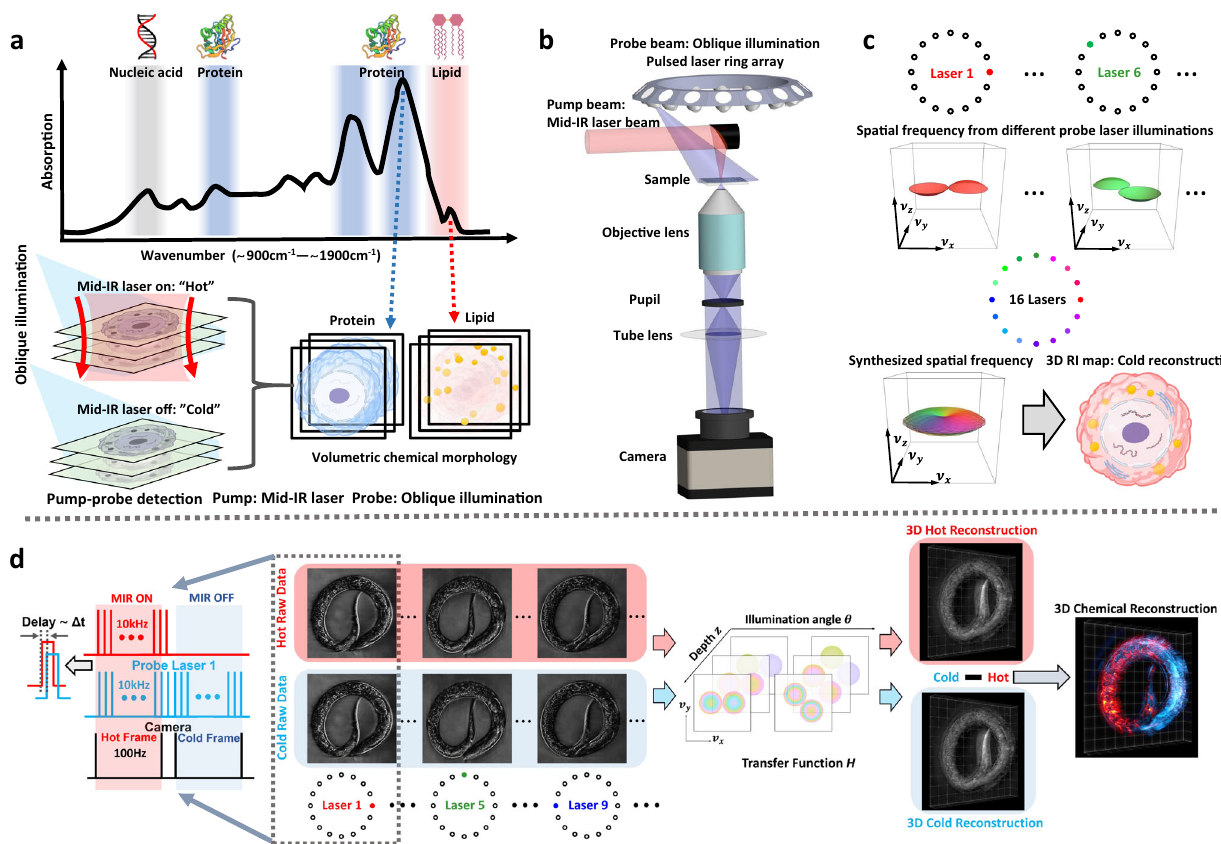
Fig. 1 | BS-IDT principle, instrumentation, and image reconstruction. a MIP- basedchemicalimagingprinciple.CreatedwithBioRender.com.Thetopinsetin “ a ” shows a mid-IR spectrum in the fi ngerprint region of ~900cm − 1 − 1900cm − 1 . Each crest in the spectrum corresponds to a unique chemical compound. The sample under mid-IR laser illumination: “ Hot ” state; sample without mid-IR laser illumina- tion: “ Cold ” state. Pump-probe detection: pulsed mid-IR laser illumination (pump beam)onthesamplecausestransientlocalRIchange.RIvariationsforhotandcold states areprobedbyanothervisibleoblique beam. 3Dchemicalmorphologymaps with different biomolecular distributions: (1) subtract hot reconstruction from the cold; (2) tune wavenumber to obtain a different chemical compound of interest. Biomolecule icons in “ a ” are created with ref.65. Cancer Cell icon in “ a ” is adapted from ref.65. b System design. BS-IDT is based on a wide- fi eld transmission micro- scope (Methods). Probe beam: oblique laser illumination (~450nm) from a laser array that consists of 16 diode lasers. Pump beam: off-axis gold parabolic mirror focuses mid-IR (MIR) laser beam from a quantum cascade laser (QCL) onto the